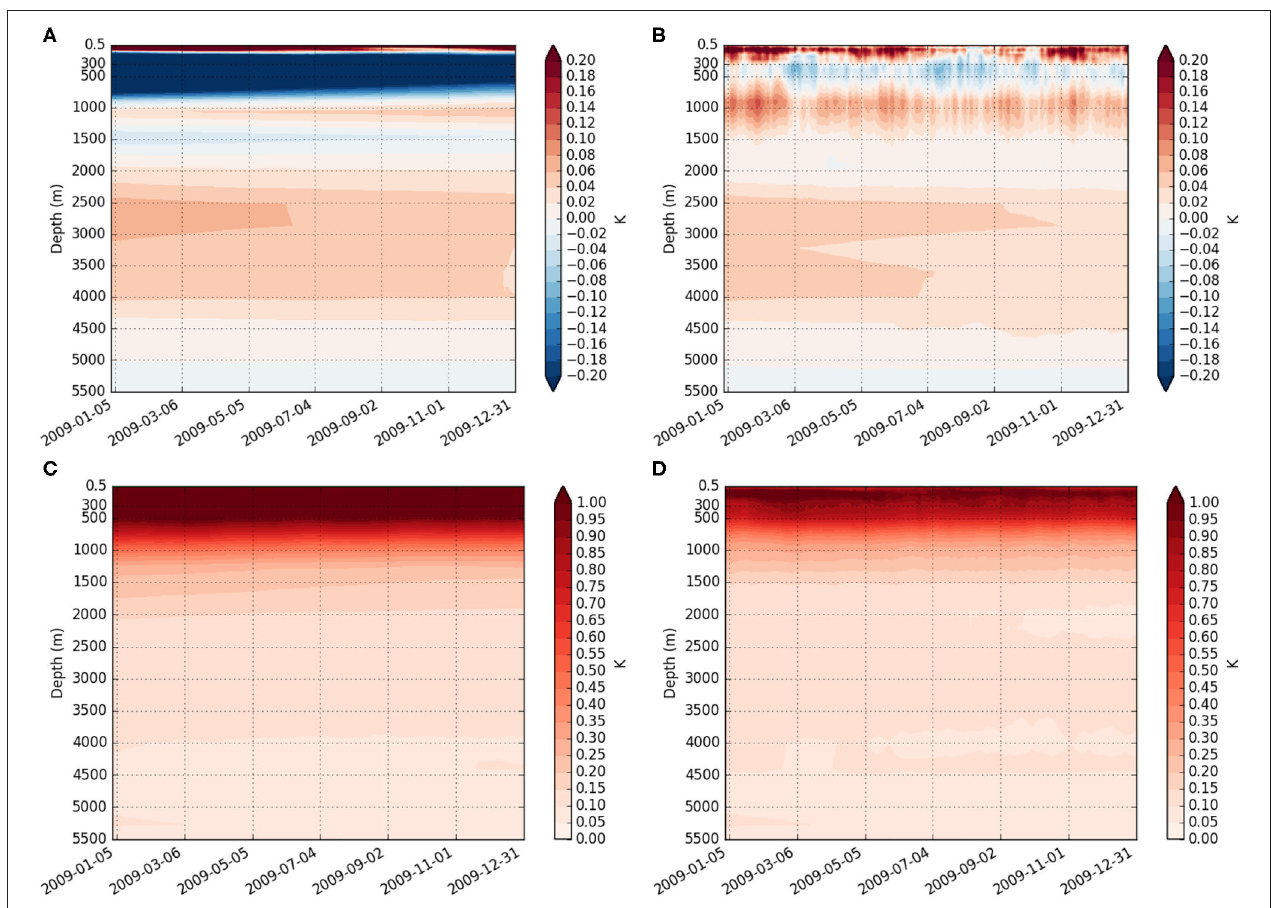
FIGURE 3 | Hovmöller plots of OSSEs-NR statistics for temperature field in the Atlantic over January–December 2009: (A) Free Run bias, (B) Backbone bias, (C) Free Run RMSE, and (D) Backbone